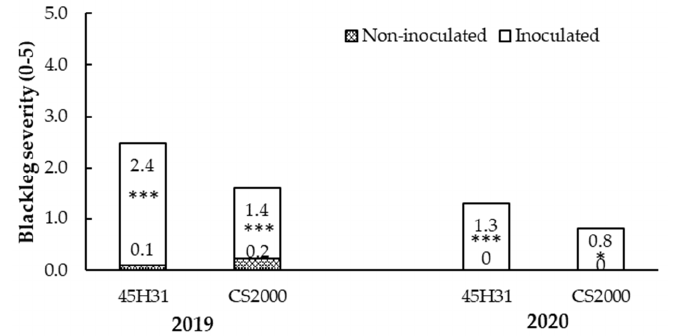
Figure 1. Mean blackleg disease severity on the canola hybrids ‘45H31’ and ‘CS2000’ under field conditions in Leptosphaeria maculans -inoculated and non-inoculated treatments. Data were collected over two years (2019 and 2020) at two sites in Edmonton, AB, Canada. Blackleg severity was assessed on a 0–5 scale, where 0 = no disease and 5 = death of the plant. Significant differences between inoculated and non-inoculated plots of each hybrid in each year are indicated with asterisks: *, p < 0.05; ***, p < 0.001. Table 1. Yield (t ha − 1 ) of canola hybrids ‘45H31’ and ‘CS2000’ in Leptosphaeria maculans -inoculated and non-inoculated treatments in field trials near Edmonton, AB, Canada, in 2019 and 2020.